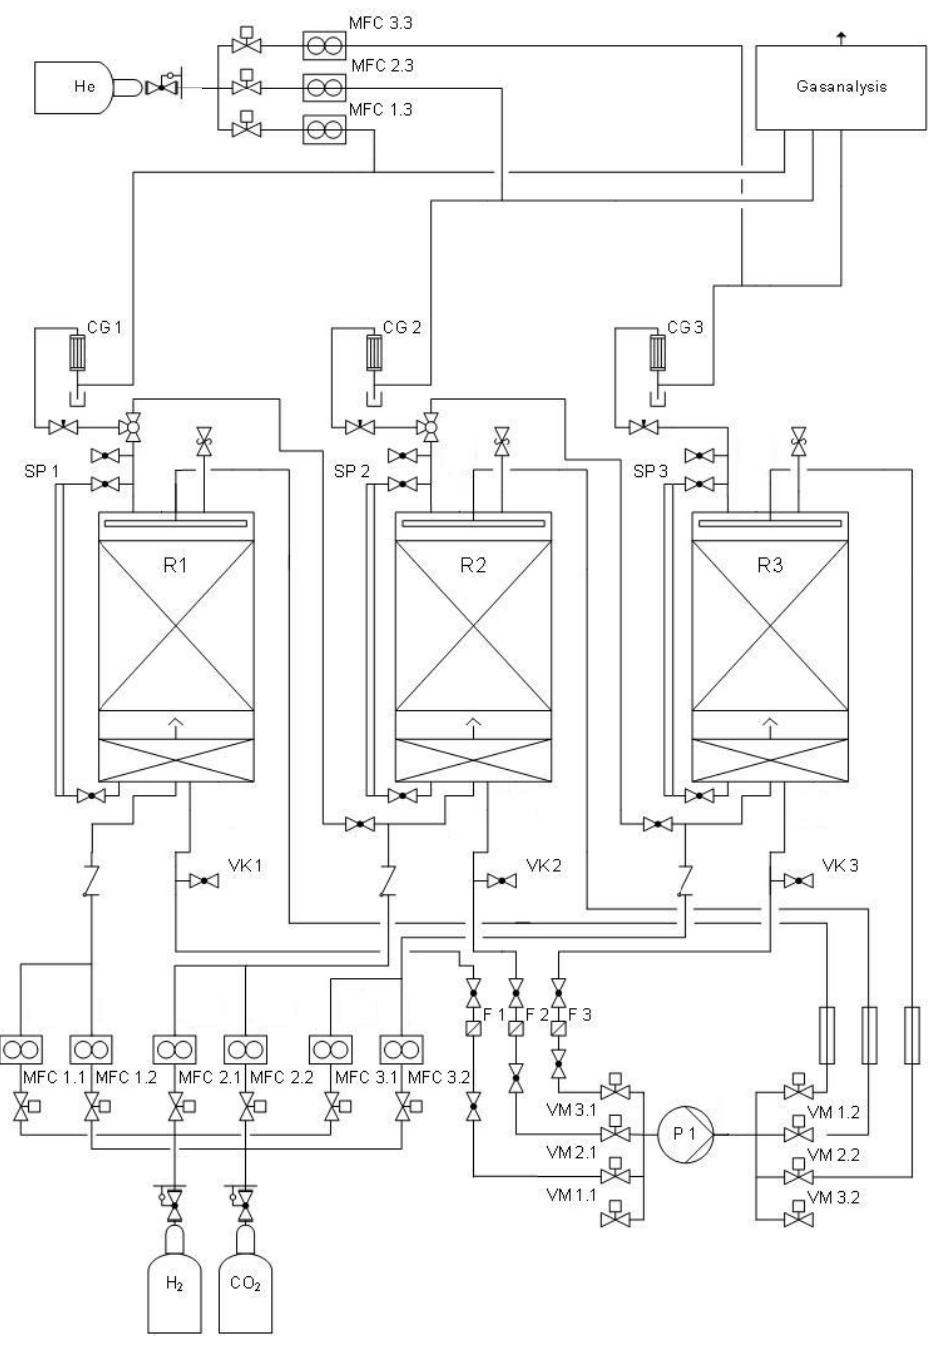
Figure 1. Piping and instrument diagram of the test facility with the three trickle-bed reactors (R1–R3), the injection of the educt gases CO 2 and H 2 (MFC 1.1–MFC 3.2), the circulation unit of the nutrient solution (P 1, VM 1.1–VM 3.2), the gas analysis and the gas quantity measurement (MFC 1.3–MFC 3.3) with He as the tracer-gas.